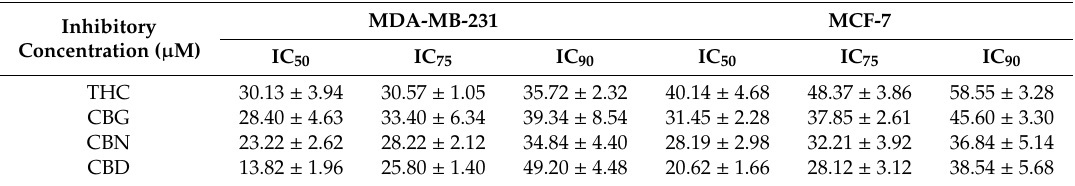
Table 1. Inhibitory concentrations of ∆ 9 -tetrahydrocannabinol, cannabigerol (CBG), cannabinol (CBN), and cannabidiol (CBD) at the selected e ff ect